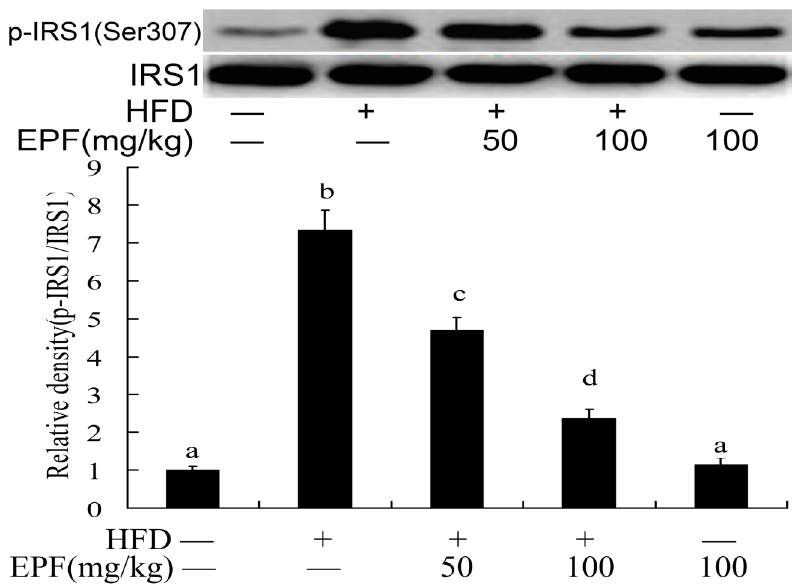
Figure 6. Western blot analysis of IRS1 phosphorylation levels in the livers of mice. The relative density is expressed as the ratio (Phospho-IRS1/IRS1). The vehicle control is set as 1.0. Significant differences among the groups were assessed by one-way ANOVA with Tukey’s post hoc test. Each value is expressed as mean ± SEM ( n = 7). Values that do not share a common superscript (a,b,c) differ significantly at p ≤ 0.05.